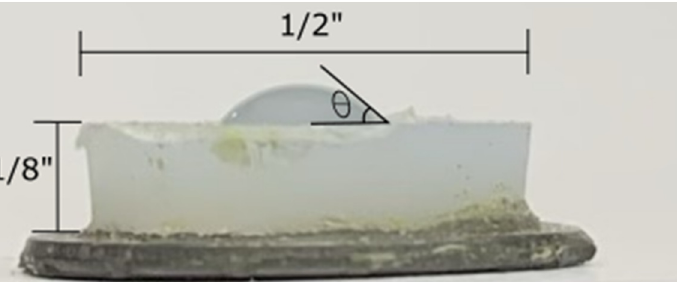
Figure 5. Representative contact angle measurement of the sample treated at the base position with a 1 L/min flow rate. 1 L/min flow